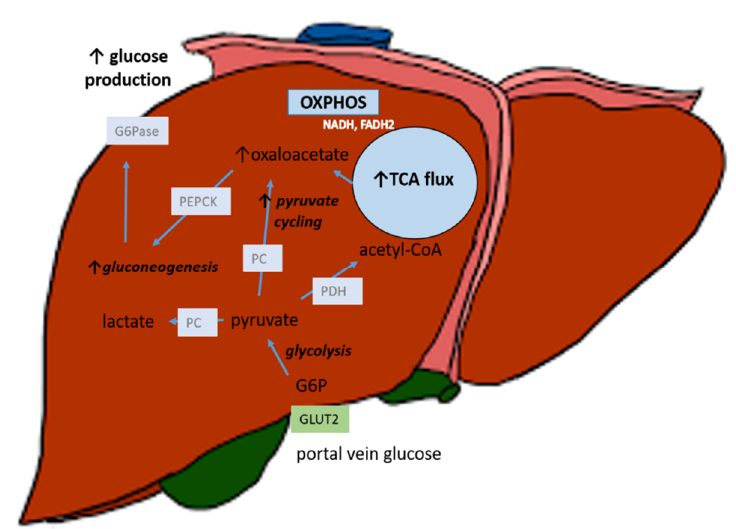
Figure 1. In the steatotic liver, increased mitochondrial tricarboxylic acid cycle (TCA) flux and increased pyruvate cycling (anaplerosis) potentially lead to increased oxaloacetate availability for gluconeogenesis. GLUT2: glucose transporter 2. G6P: glucose-6-phosphate. PDH: pyruvate dehydrogenase. PC: pyruvate carboxylase. PEPCK: phosphoenolpyruvate carboxykinase. OXPHOS: oxidative phosphorylation.